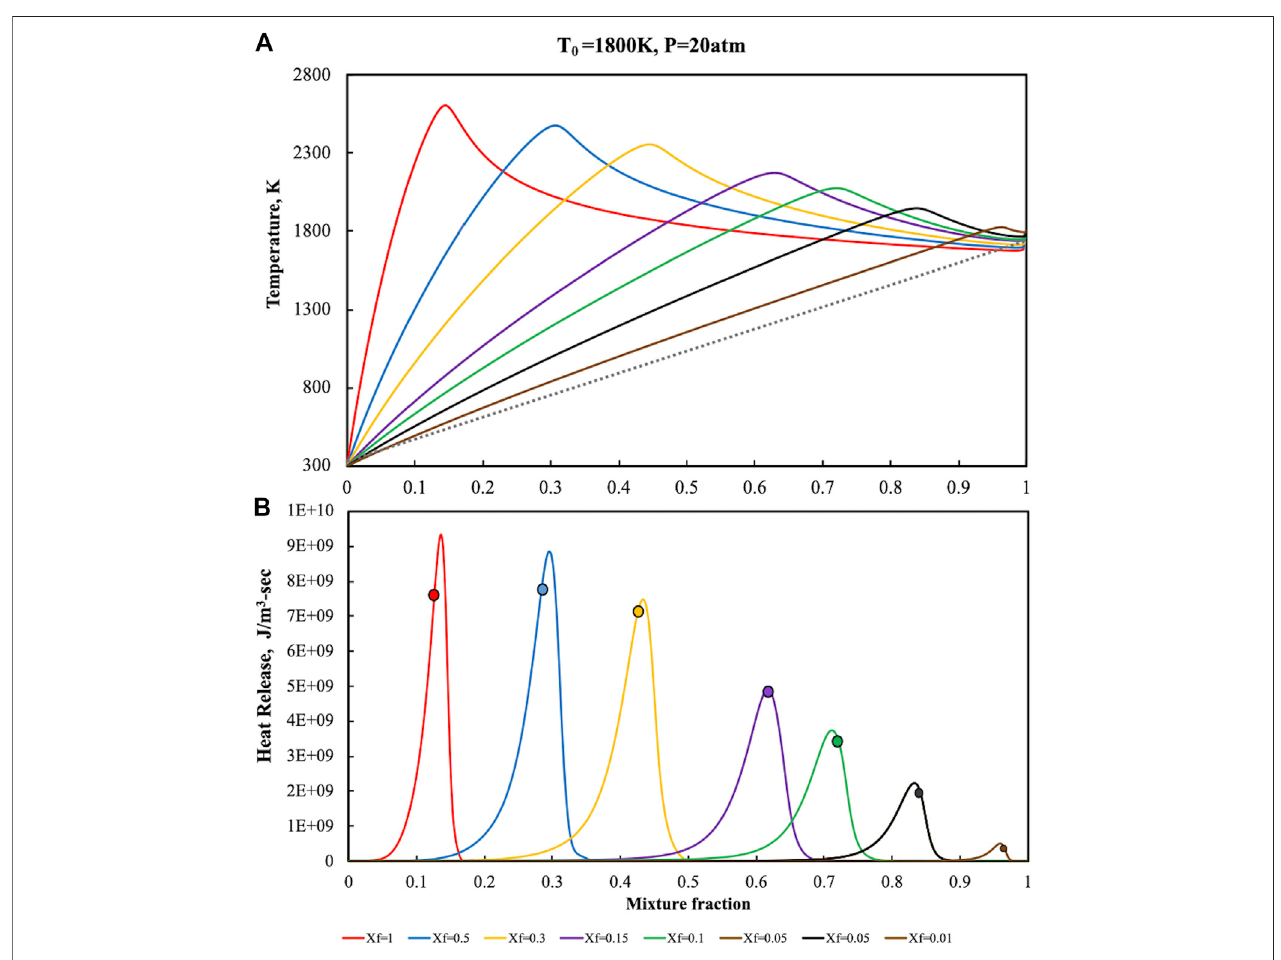
FIGURE 7 | Temperature (A) and heat release (B) pro fi les for pure ammonia parametric in X f in the HFDF con fi guration for T 0 (cid:1) 1,800 K, K 0 (cid:1) 50 s − 1 , P (cid:1) 20 Atm.